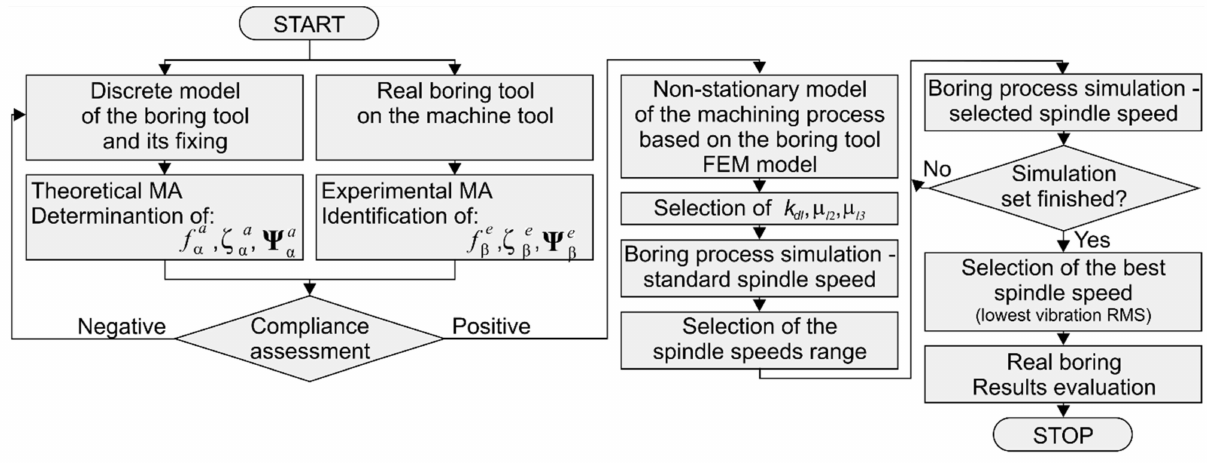
Figure 4. Scheme of choosing the best spindle speed in the process of boring large-sized workpieces using E-AVP. The scheme is based on